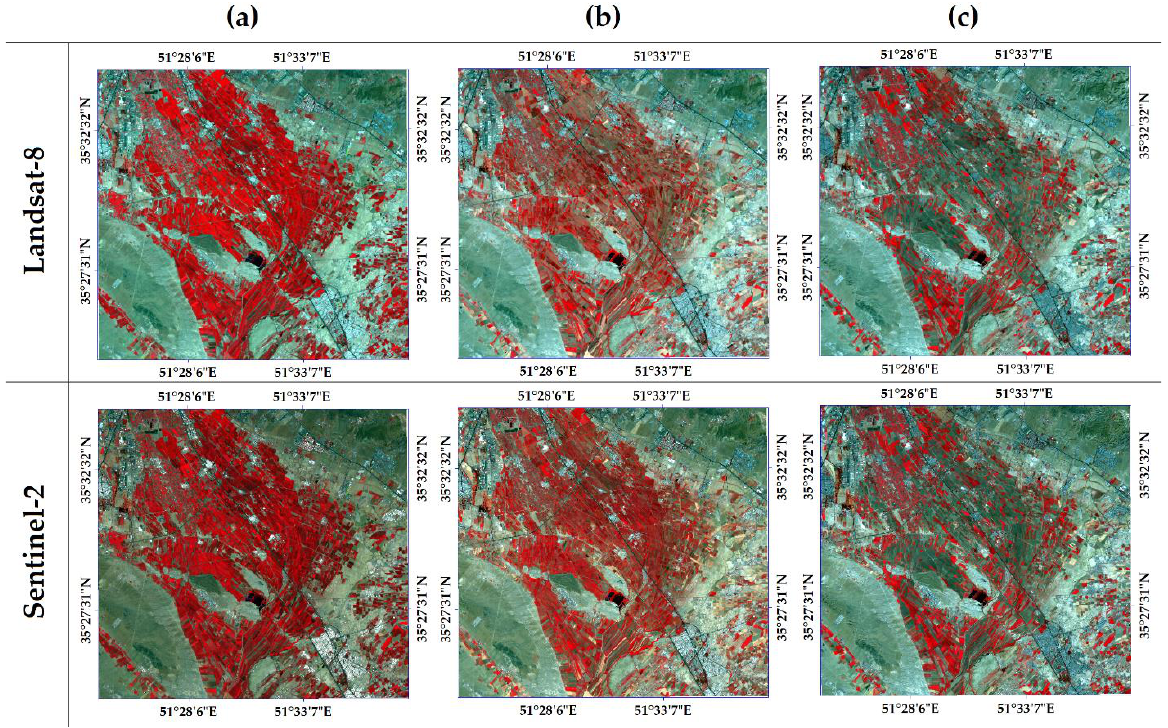
Figure 4. Comparison of different seasonal composites. False-color images (R: near infrared (NIR), G: red, and B: green) from Landsat-8 and Sentinel-2 time series. ( a ) Spring, ( b ) summer, and ( c ) autumn.